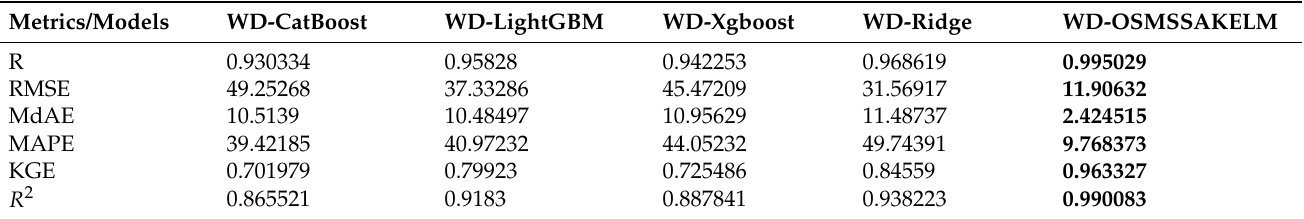
Table 6. Comparison results of the proposed model for the testing phase versus other studied models based on different metrics.